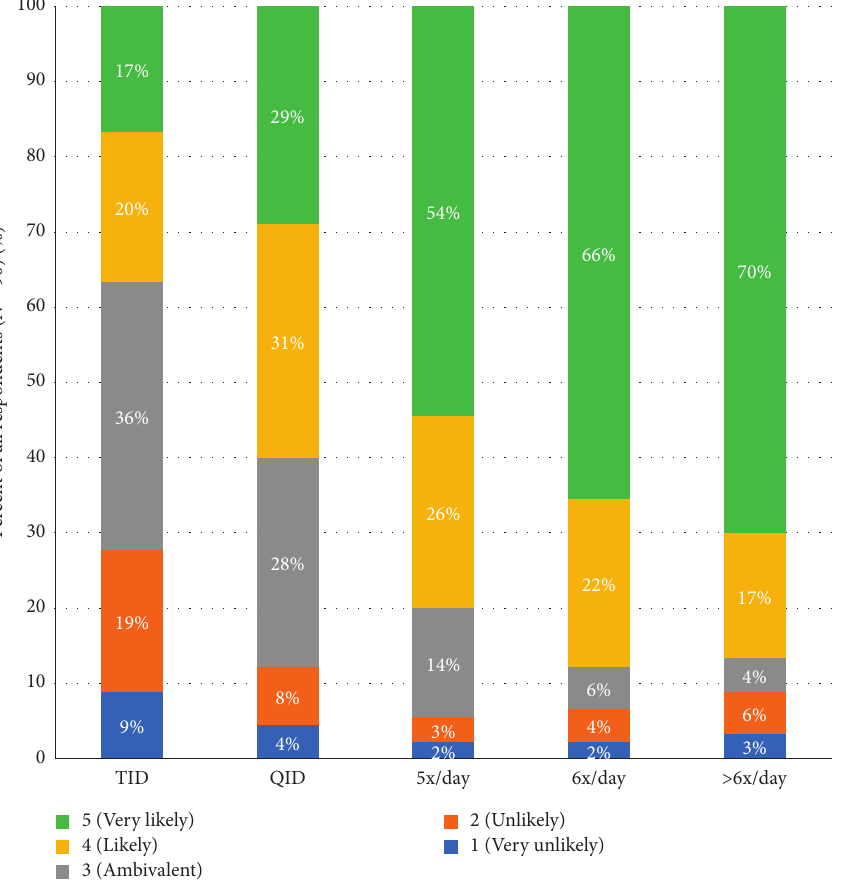
Figure 4: Likelihood of switching to CD-LD ER: multiple OFFs and dyskinesia per CD-LD IR dosing frequency.